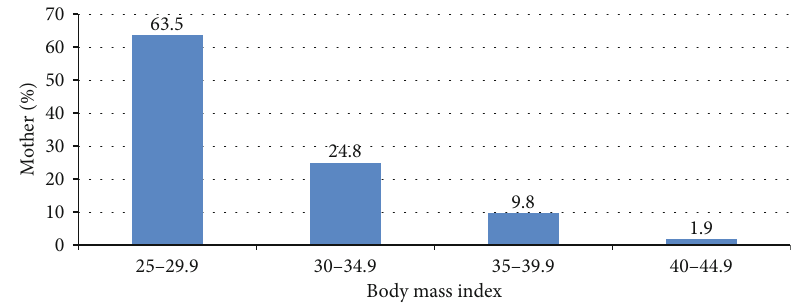
Figure 2: Bar graph showing the percentage of mothers against their body mass index.